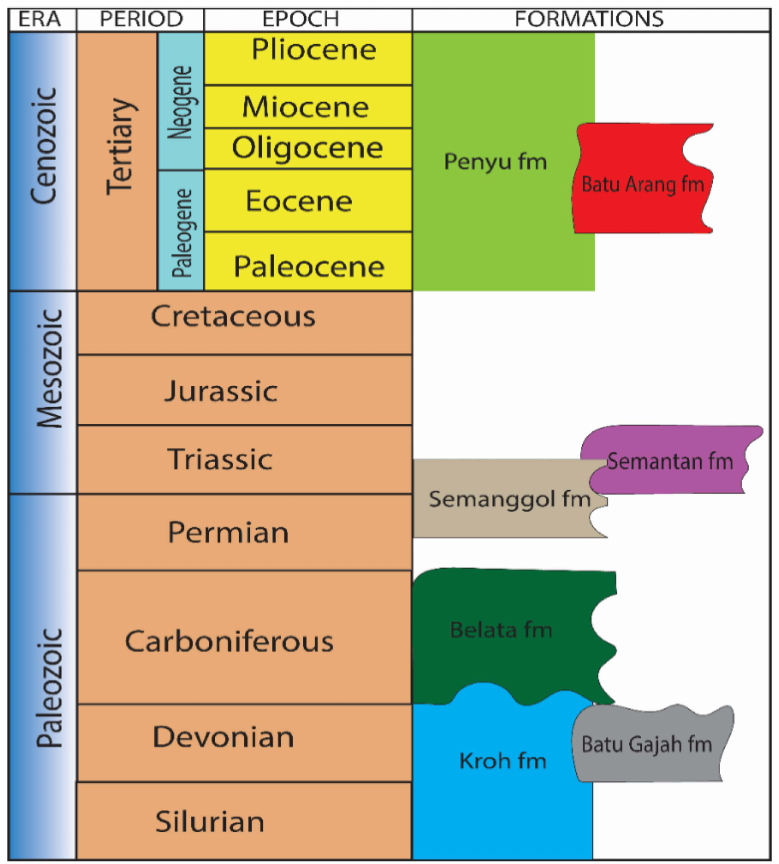
Figure 2. Stratigraphy of the formations studied in Peninsular